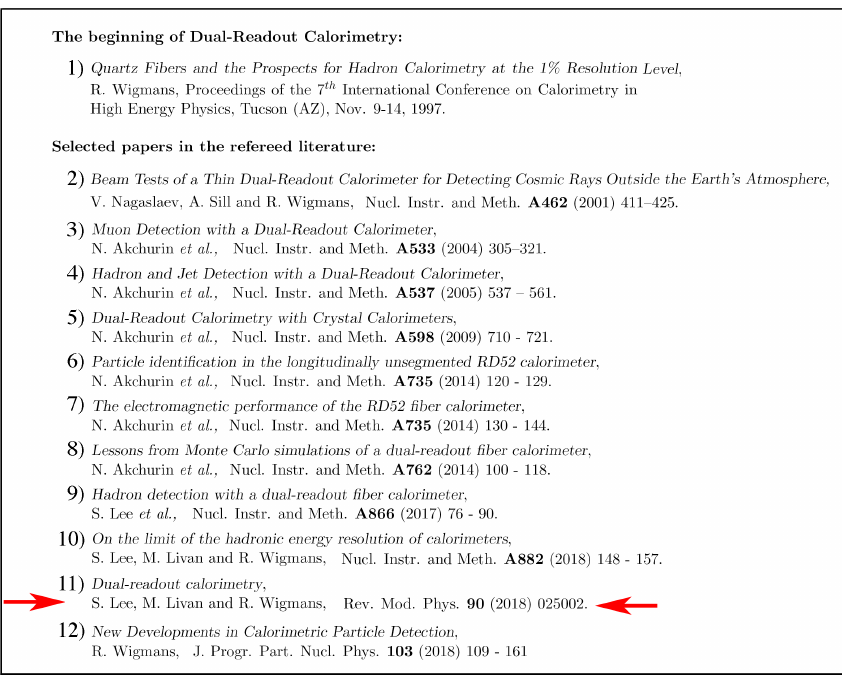
Table 1. A chronological selection of publications on dual-readout